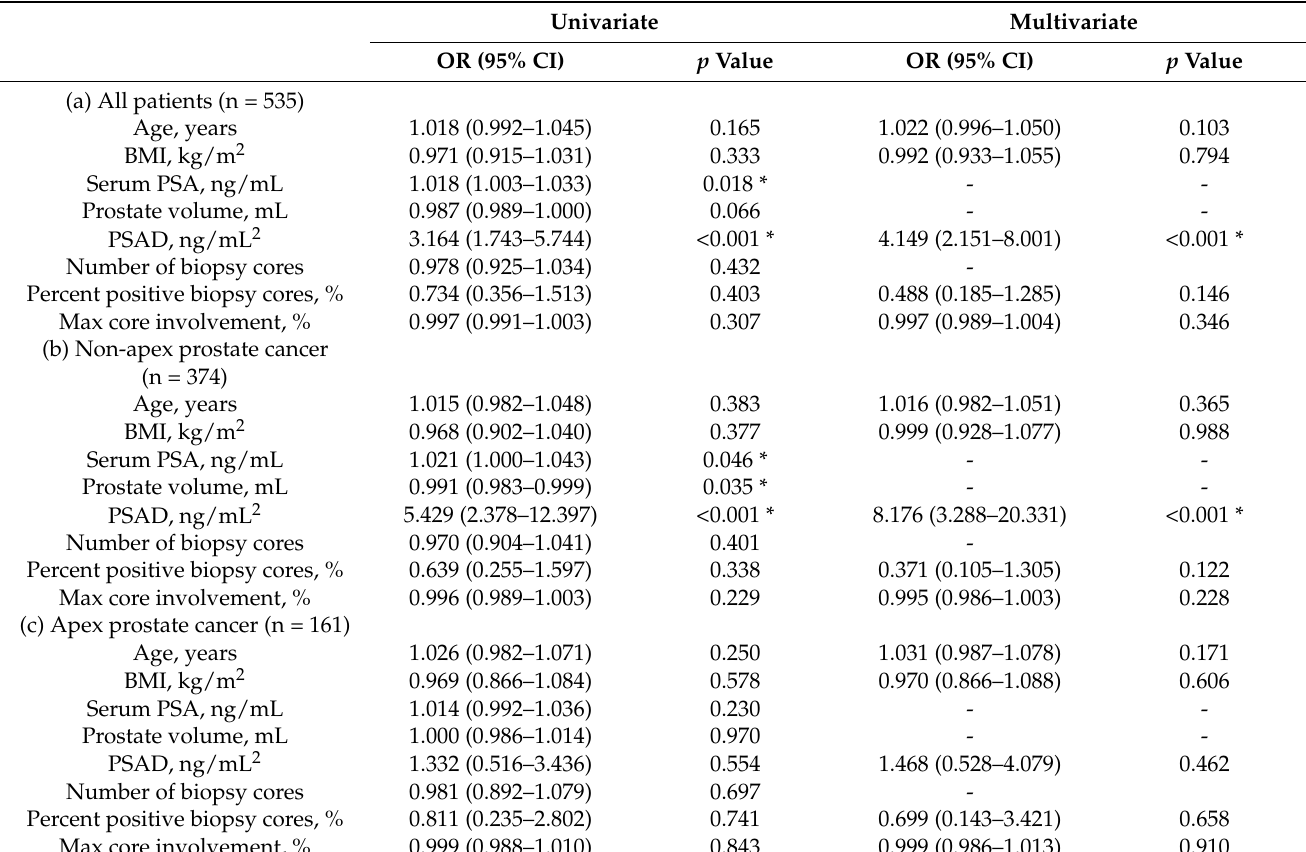
Table 2. Univariate and multivariate analysis for predicting GG upgrading. Univariate Multivariate OR (95% CI) p Value OR (95% CI) p